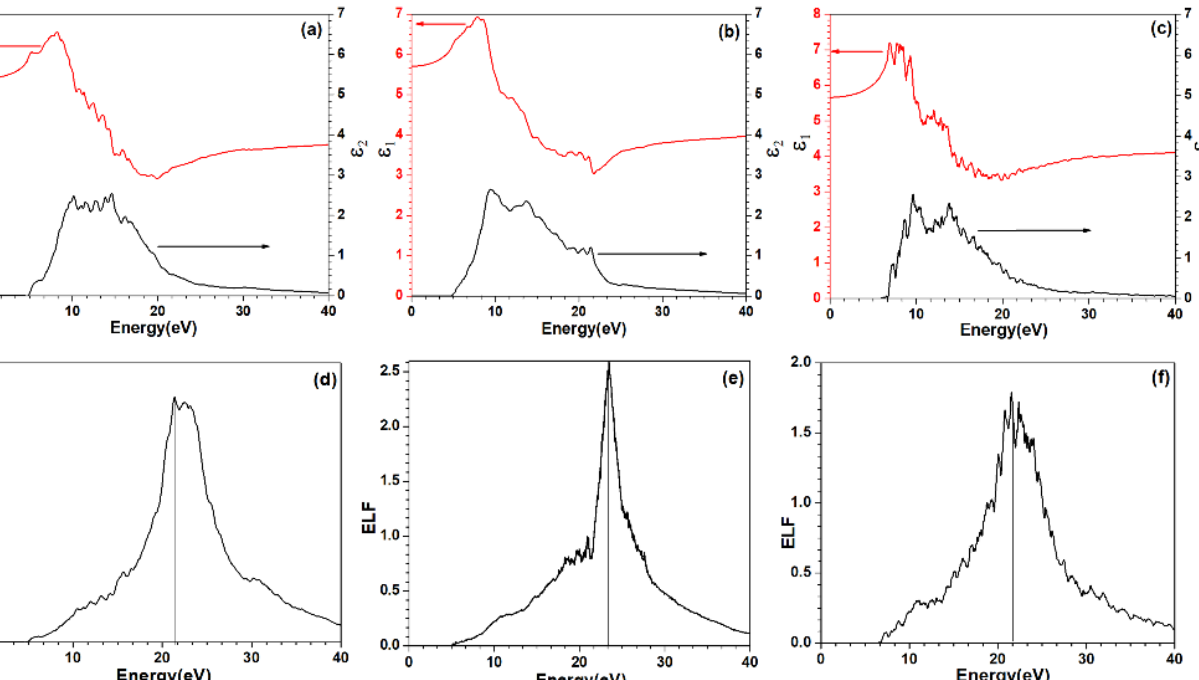
Figure 5. Distribution of partial charge Δ Q* for ( a ) kaolinite, ( b ) muscovite, and ( c ) montmorillonite.